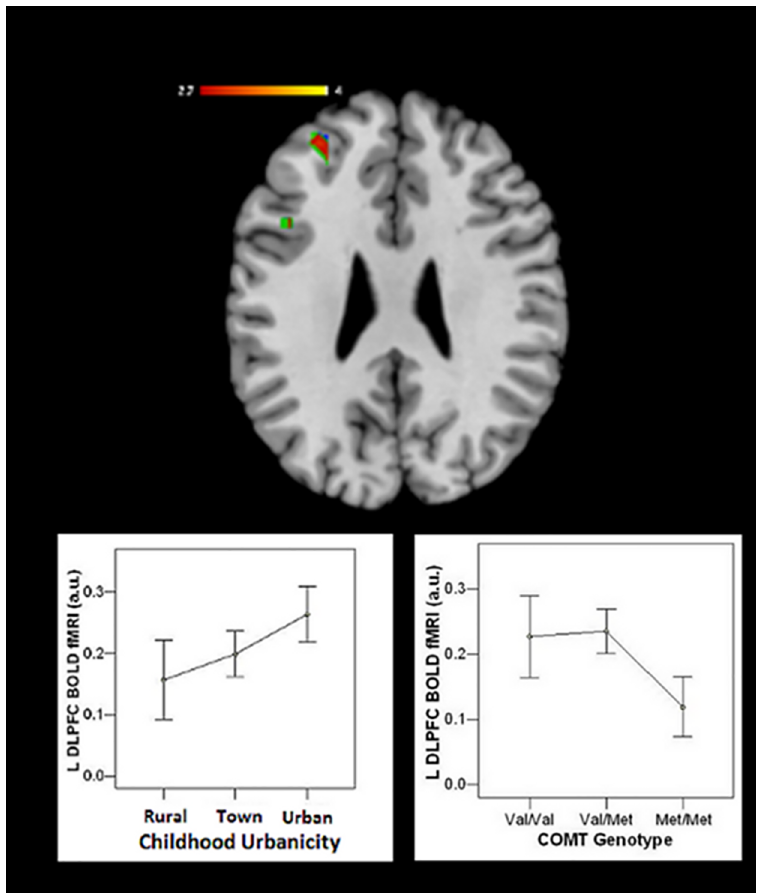
Fig 1. Urban upbringing and COMT Val/Val associated with prefrontal working memory inefficiency. In the top center image, main effects of urbanicity (green), COMT (blue), and their overlap (red) are presented. Graphs in the lower left (urbanicity) and lower right ( COMT genotype) use values extracted from the imaging analysis to illustrate that both urban upbringing and COMT Val genotype predicted greater prefrontal activation during working memory at discovery. The fMRI activation threshold is p < 0.005 (uncorrected). Parameter estimates are graphed in arbitrary units (a.u.) (mean ± standard error). Left =